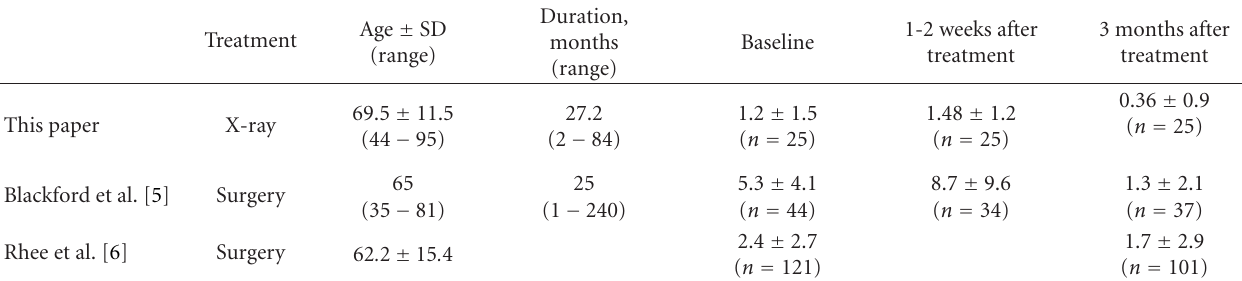
Table 4: Changes in total DLQI scores between baseline and after di ff erent treatments. Mean score ±